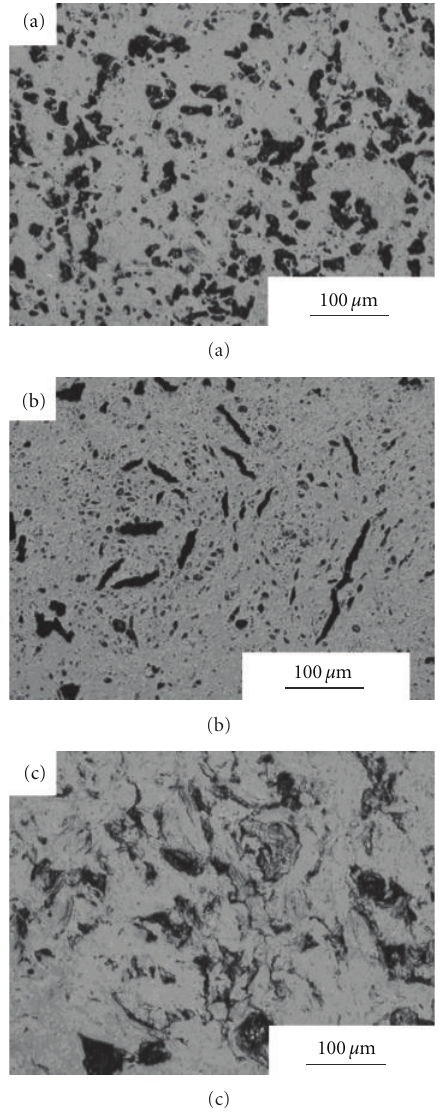
Figure 7: Graphite morphology after 200 keV Xe + irradiation with flux of 1 × 10 14 ions/cm 2 . (a) IG-11; (b) NBG-18; (c) HSM-SC. The overlapping of peaks appears in 200 keV Xe + irradiation at flux of 1 × 10 15 ions/cm 2 , which indicates much heavier destruction of structure. The Raman spectra of NBG-18 and HSM-SC give similar